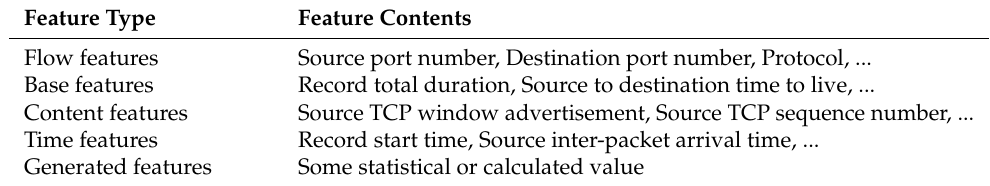
Table 2. Features list in business feature